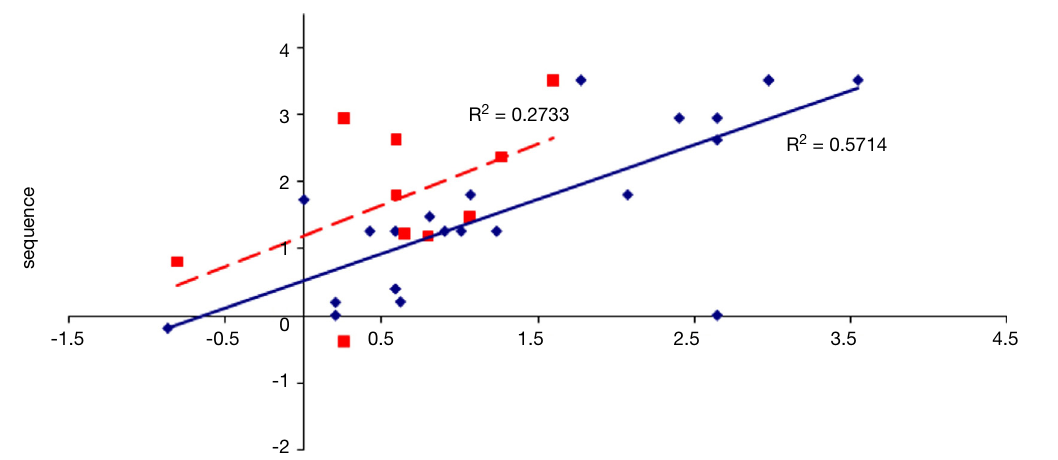
Figure 12 | Scatter plot of performance on the spatial and sequence tasks with linear fi t and R -squared values for control (Experiment 1, in red squares and dashed line) and college-age (Experiment 3, in blue circles and solid line) participants. Both correlations are signifi cant.